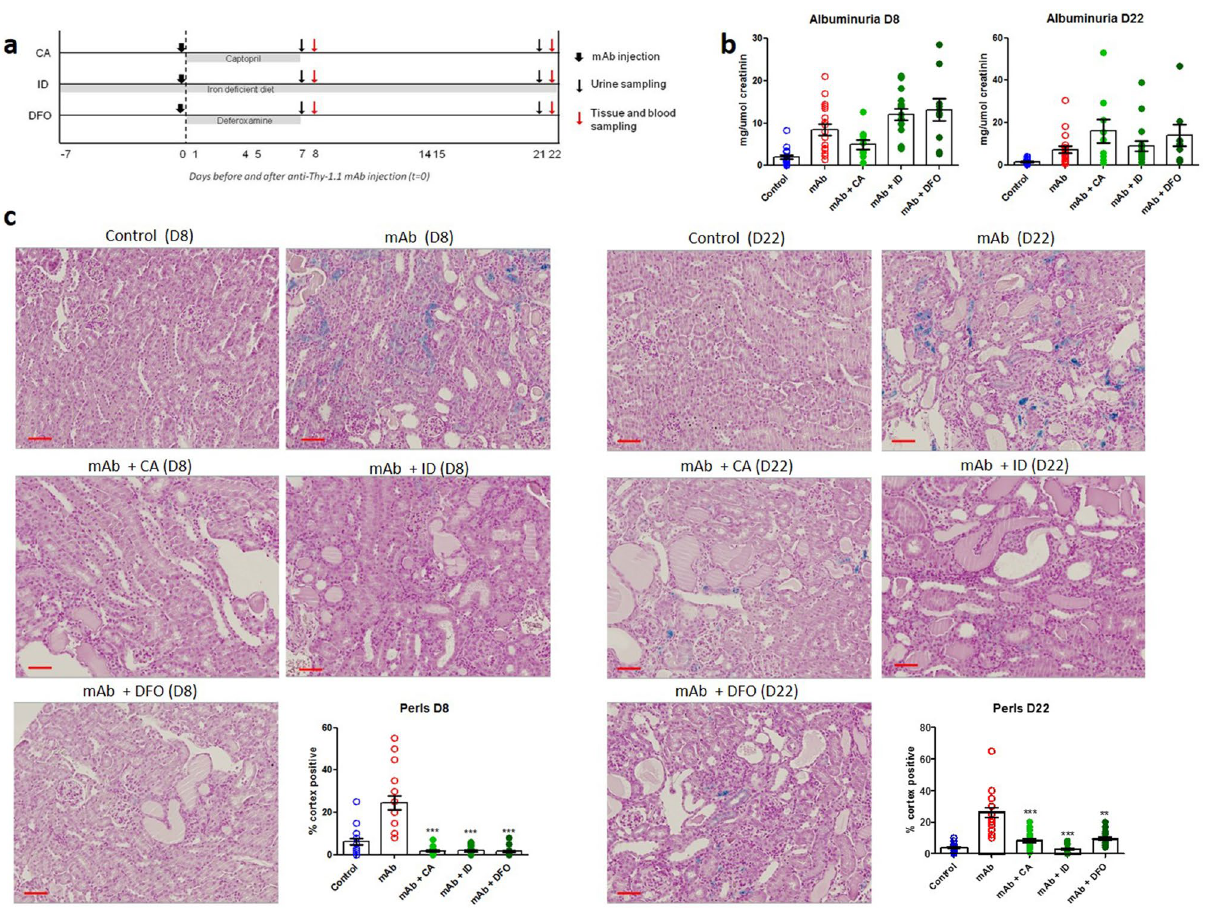
Figure 5. Iron-reducing interventions diminish kidney iron loading in mAb-injected mice. Schematic overview of experimental setup using CA, ID and DFO ( a ). Albuminuria was not significantly changed by CA, ID or DFO at D8 and D22 after mAb-injection compared to mice treated with mAb alone ( b ). Kidney iron deposition at D8 and D22 was significantly reduced in mAb-injected mice co-treated with CA, ID and DFO compared to mAb alone ( c ). ***p < 0.001 compared to mAb using one-way ANOVA Kruskal–Wallis test; D day, mAb monoclonal antibody, CA captopril, ID iron-deficient diet, DFO deferoxamine. Scalebar = 50